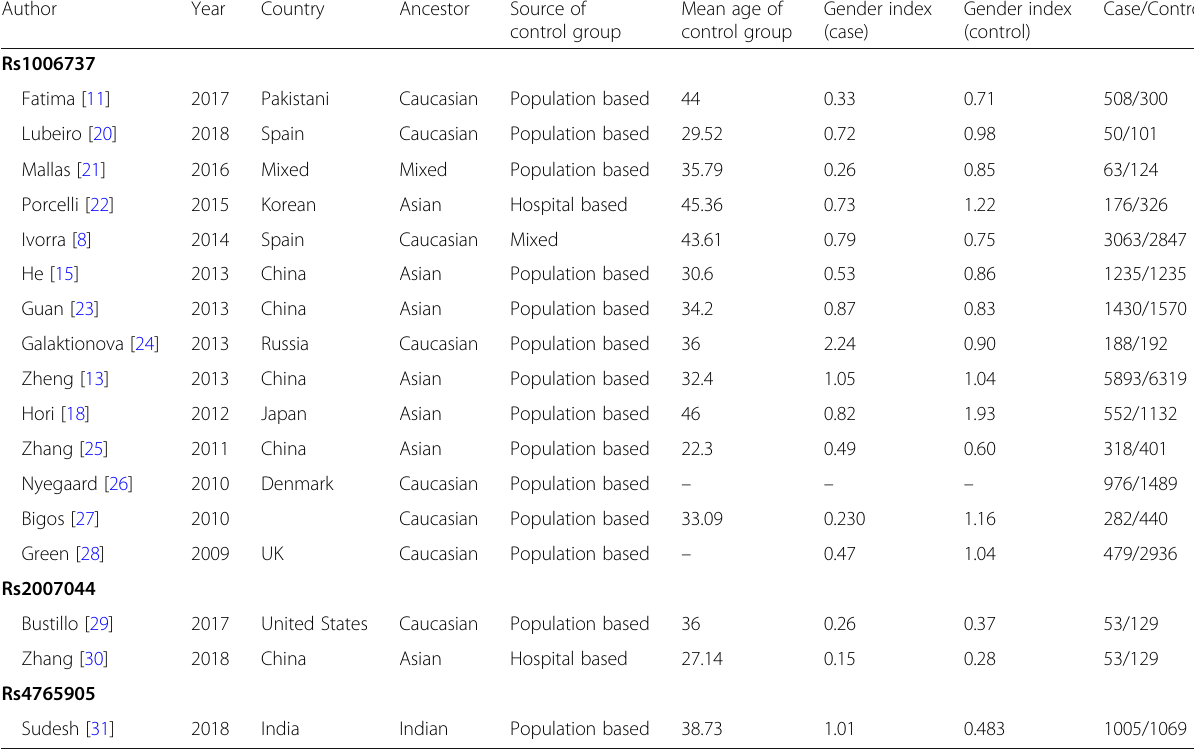
Table 1 The main characteristics of the studies included in the meta-analysis